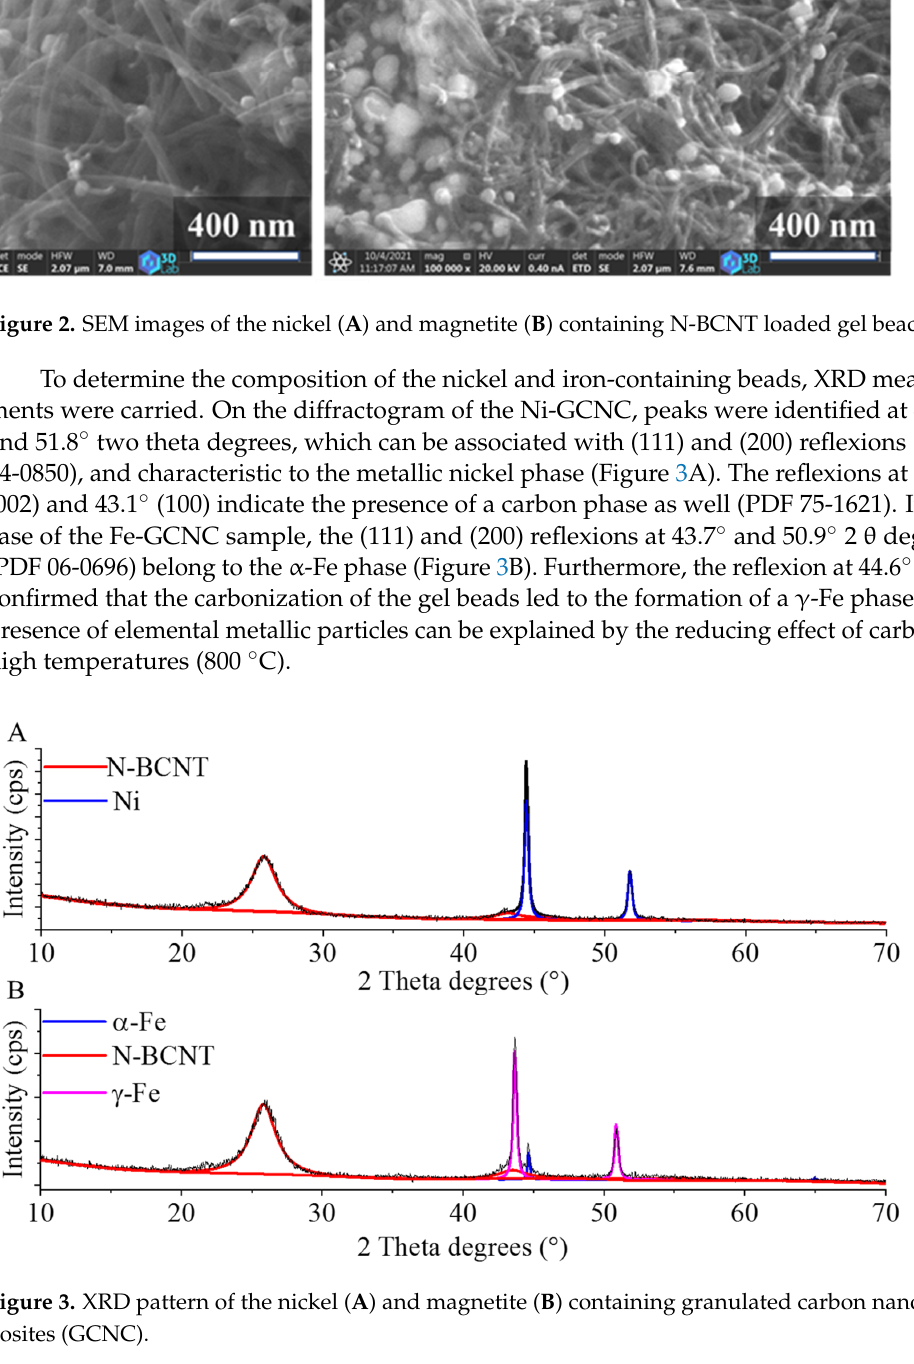
Figure 3. XRD pattern of the nickel ( A ) and magnetite ( B ) containing granulated carbon nanocom- posites (GCNC).